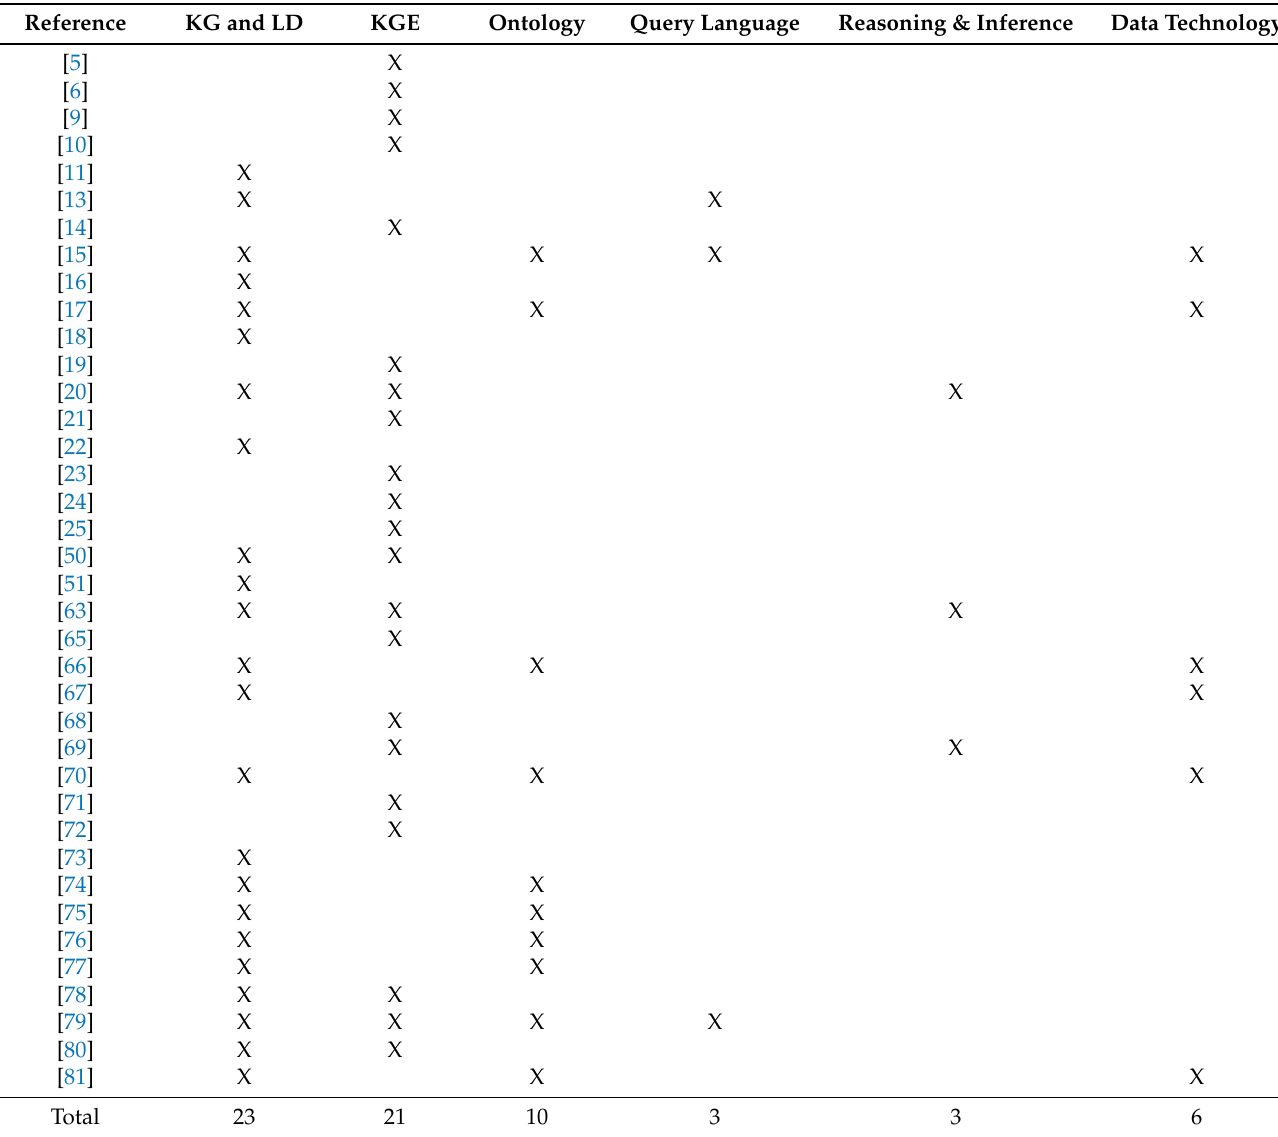
Table 1. Knowledge graphs and semantic